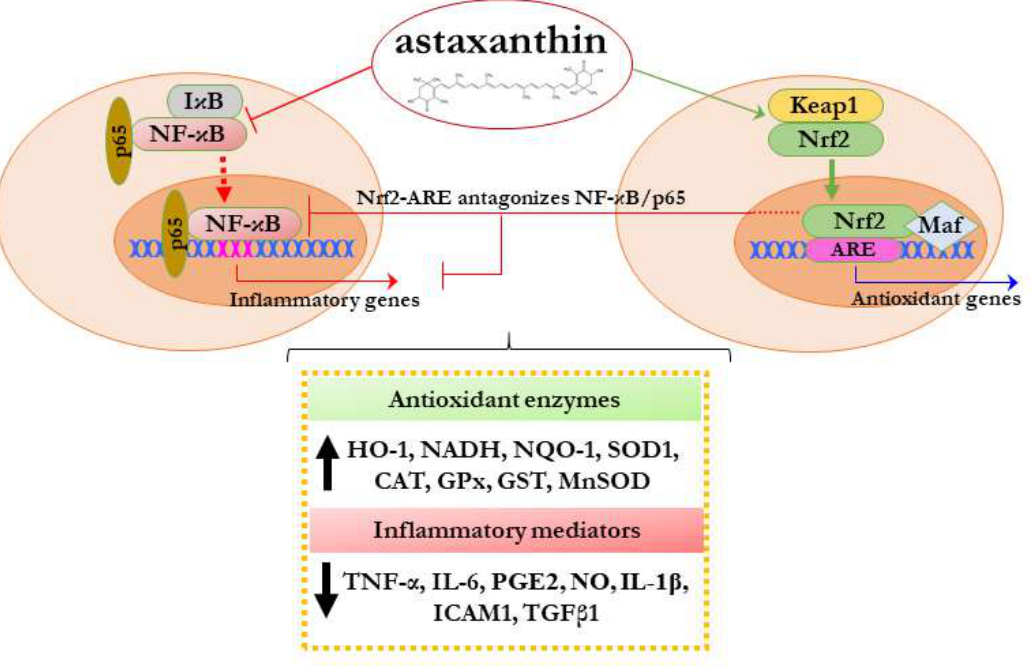
Figure 2. Schematic representation of the effect of astaxanthin on Nrf2 and NF-κB response pathways.